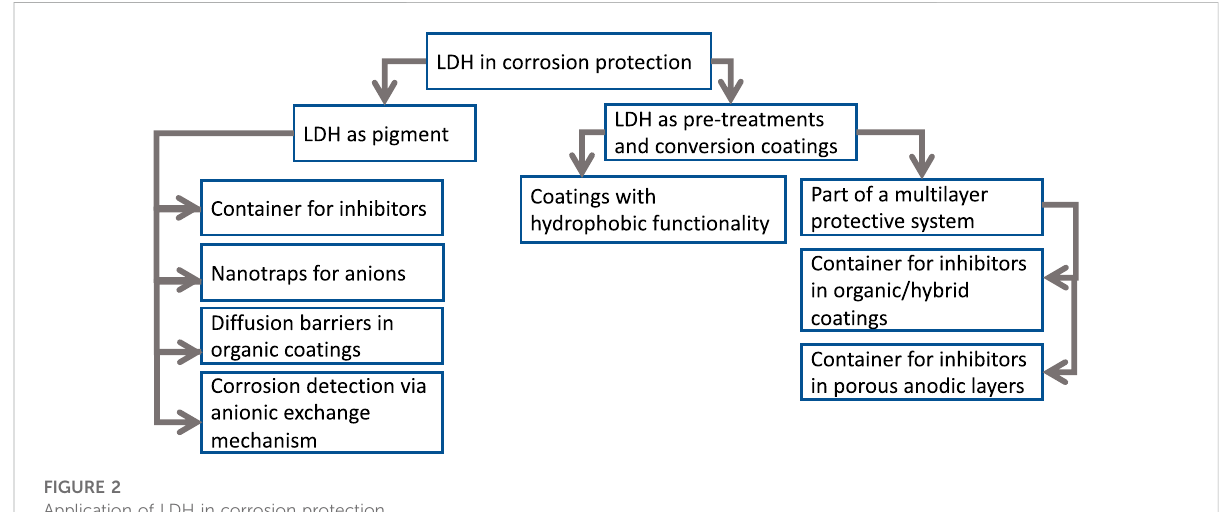
FIGURE 2 Application of LDH in corrosion